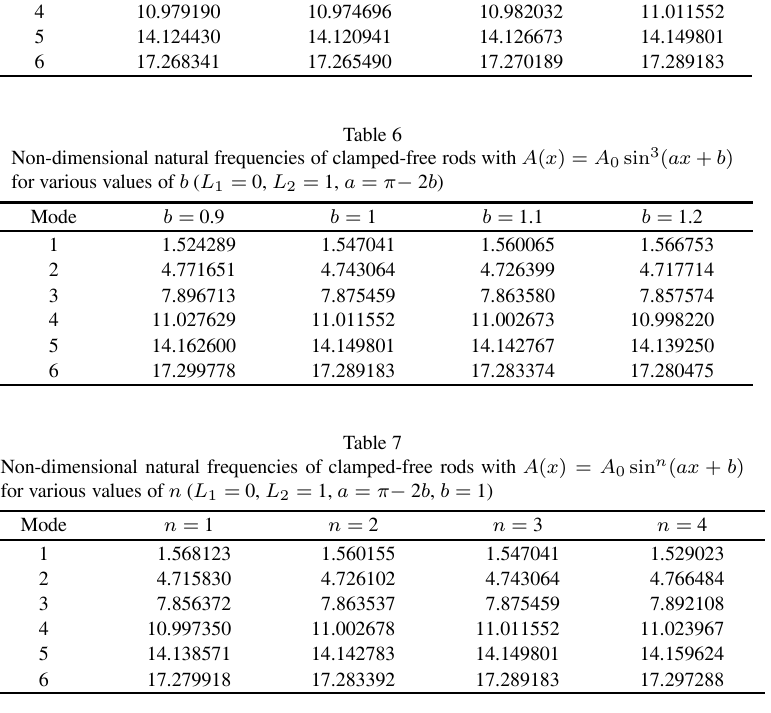
Table 8 Non-dimensional natural frequencies of free-free rods with A ( x ) = A 0 sin 3 ( ax + b )